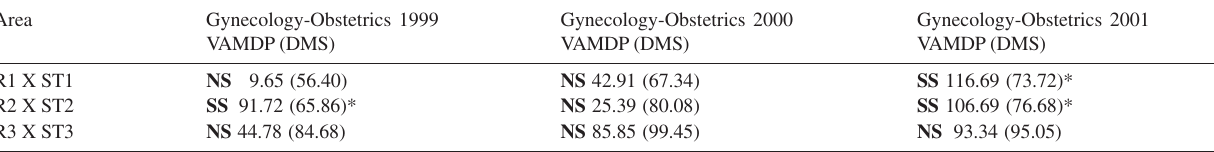
Table 8 – Comparative analysis of average correct answers in gynecology-obstetrics imaging in 1999-2001 (*P< 0.001) Area